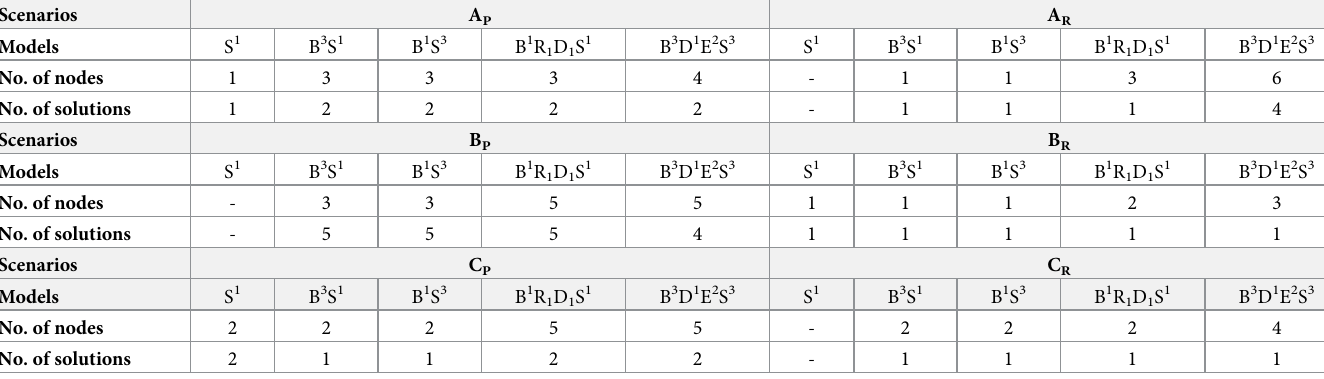
A: Node selection based on heterozygosity (H E ) values. B: Node selection based on estimated population size. C: Node selection based on element occurrence (EO) values. For each scenario, nodes included in the subgraph represented populations with the largest (Proactive) or smallest (Reactive) parameter values. Scenarios for which no nodes were selected (-) are also